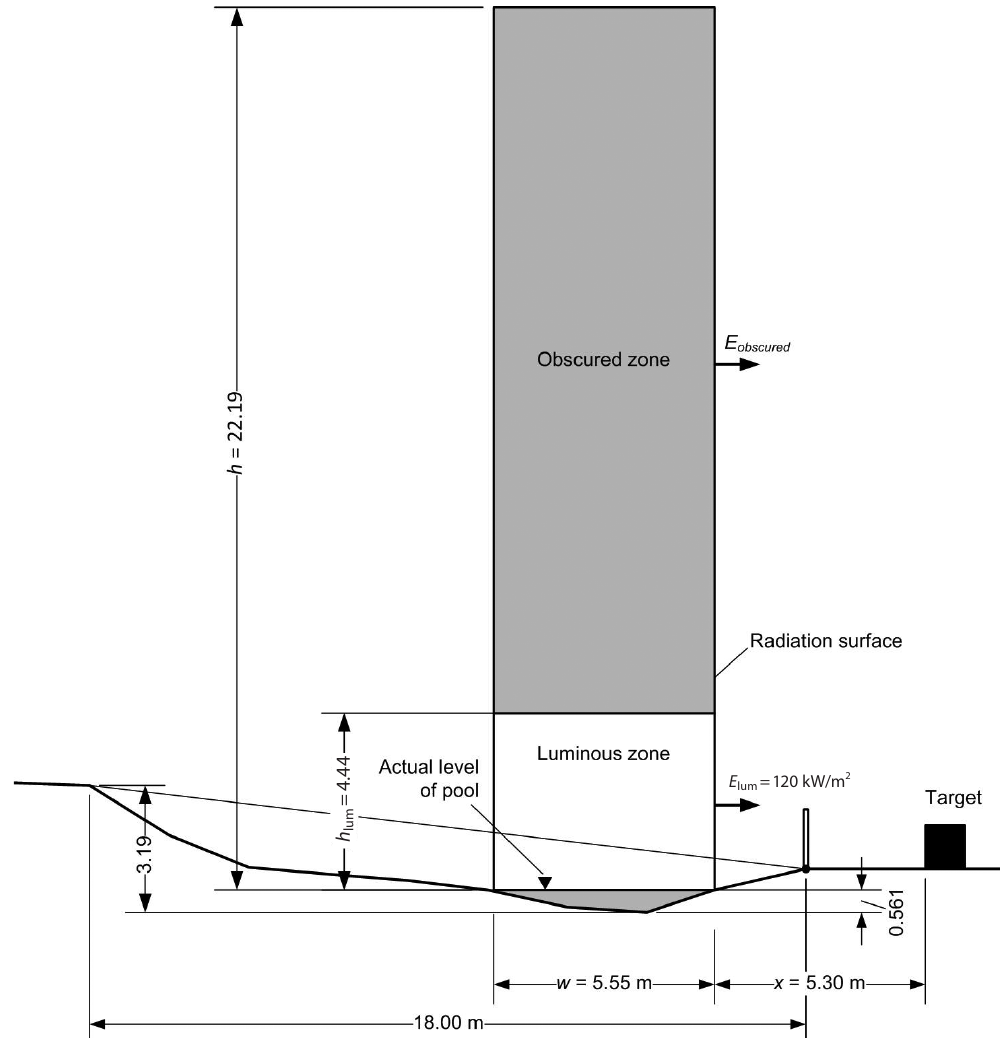
Figure 11. The configuration of the solid flame with luminous and obscured zones depicted for the pool length l = 25 m and width w = 5.55